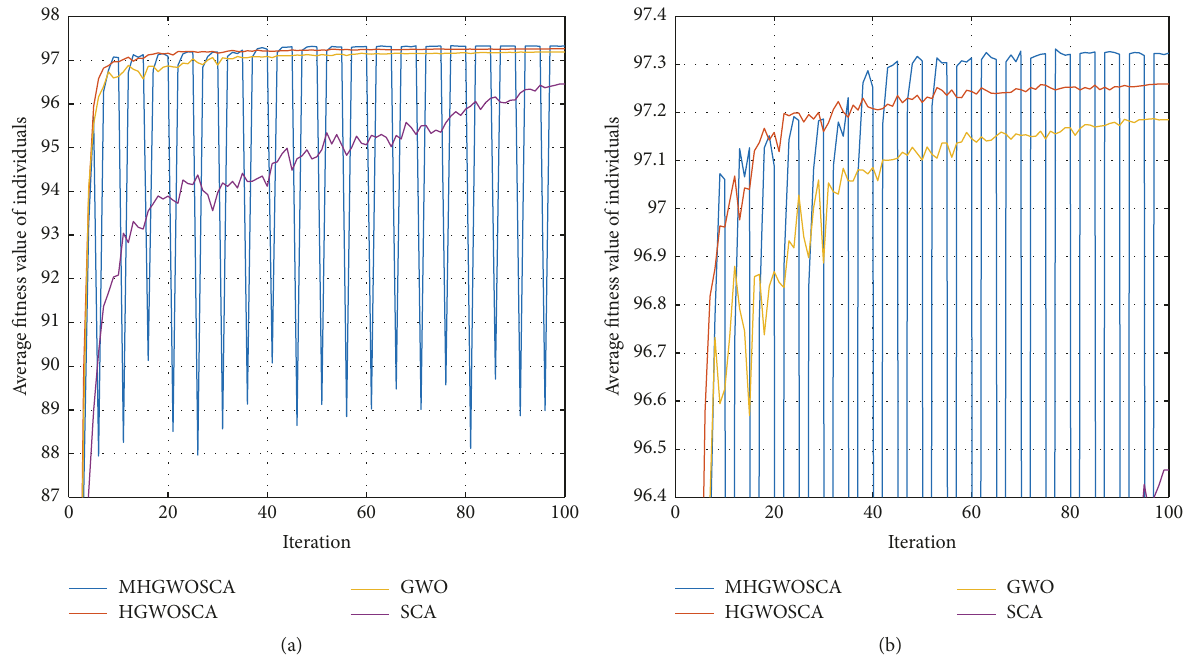
Figure 9: Comparison of different optimization methods: (a) overall trend, (b) partial enlarged detail.